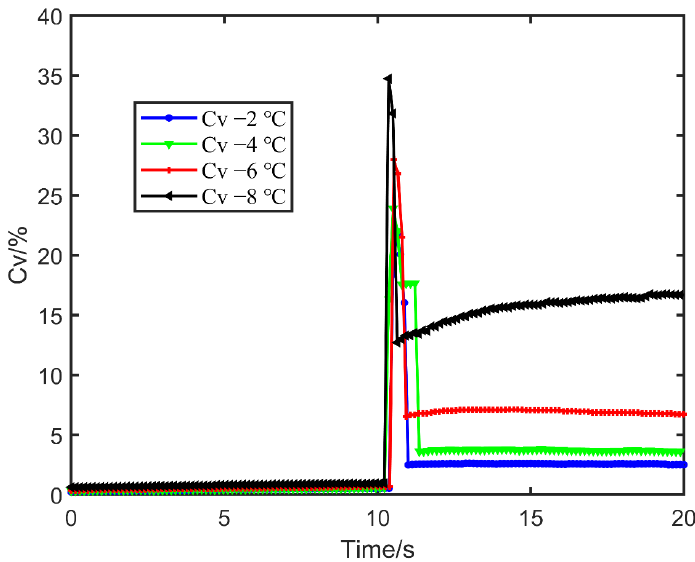
Figure 5. Evolution of voltage uniformity with different temperatures at 0.15 A/cm 2 .